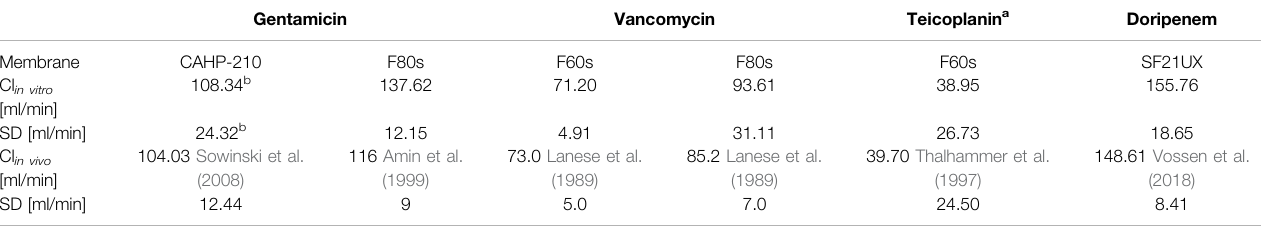
TABLE 2 | Comparison of in vitro and in vivo clearance values. Clearance values in this table were calculated as described in each referenced original publication.